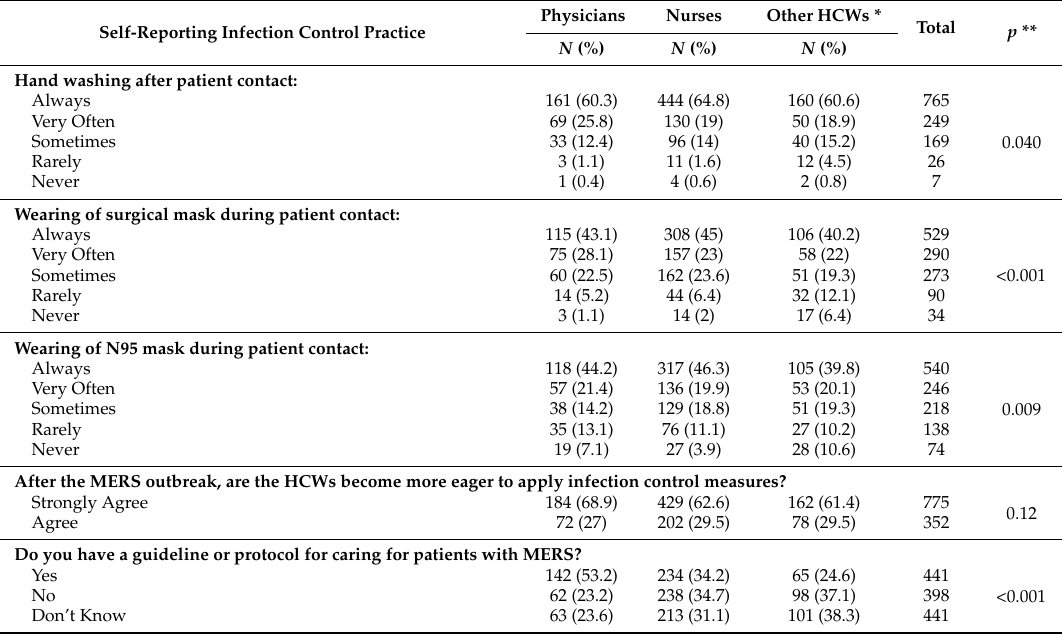
Table 3. HCWs attitudes and barriers to infection control practices following MERS-CoV